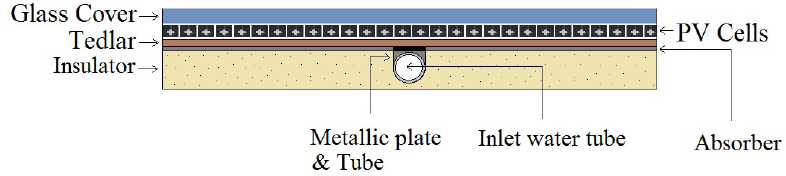
Figure 1. Sectional view of water-based photovoltaic-thermal (PV/T) collector. The second category has a channel where it is either installed on top or under the PV module. The third category of water-based PV/T collector uses two absorbers, where a